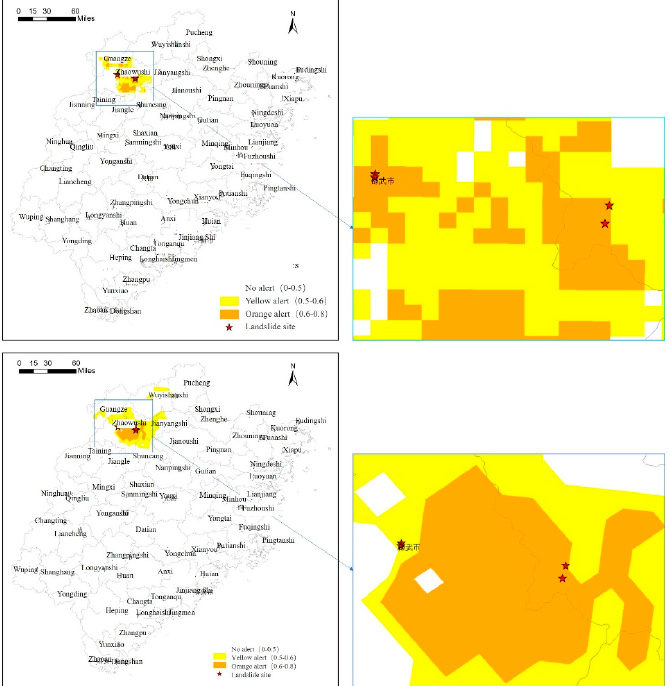
Figure 11. Comparison of early-warning results of different models on June 28, 2021 (above: early-warning results of Random Forest model; below: explicit statistical model warning results). By comparing the results of the two models, it can be seen that the hit rate of the new model based on the Random Forest was six times that of the original model (22 June) or equivalent (28 June), and the landslide density in the early-warning area of the new model was 1.6–1.7 times that of the original. Meanwhile, it can be seen from Figure 11 that no landslide occurred in WuYiShanshi area (upper right corner of the figure frame). There is no warning area in the warning results of the Random Forest model, and there is a certain range of yellow warning areas in the warning results of the explicit statistical model warn- ing results. The preliminary verification shows that the new model based on the Random Forest has obvious advantages with a higher hit rate, smaller warning area, and more accurate warning. Since there are few new landslide disasters in the study area, the cur- rent model verification work is relatively weak, and we will continue to track the new landslide disasters in the study area and strengthen the model validation and correction. 6. Conclusions